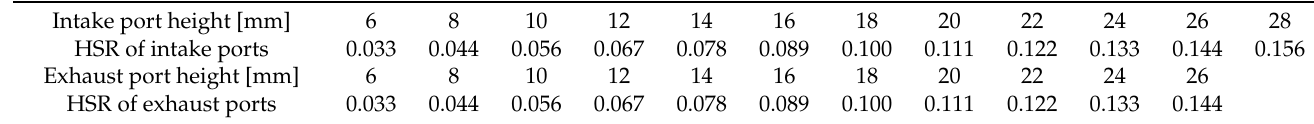
Figure 2. Schematic of port structure parameters for the OP2S diesel engine. Table 2. Parameters of intake and exhaust ports.